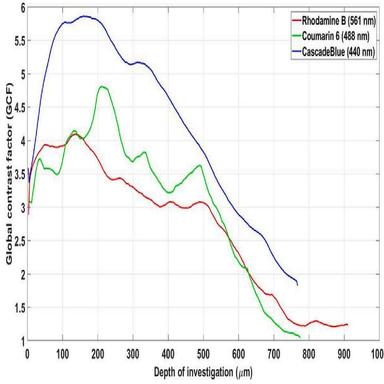
Computed GCF throughout the depth of investigation of the z-stacked confocal images presented in Fig. 3. Higher GCF indicates the larger and clearer difference between the two phases, i.e., pores and grains.